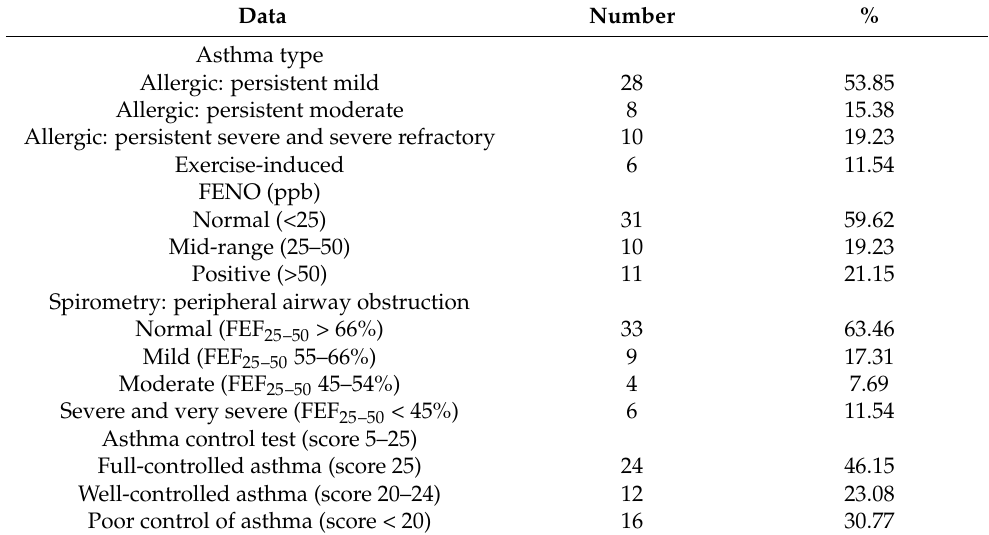
Table 2. Asthmatics: file properties.